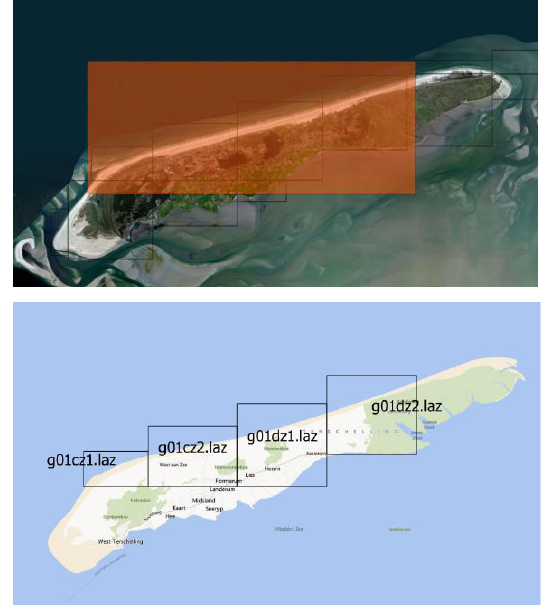
Figure 5: Example result of a spatial query visualized using QGIS. In the top image the red box represents the search polygon. The bottom image shows the tiles that are completely within the search polygon. The MongoDB spatial query delivered four tiles on the coast of the